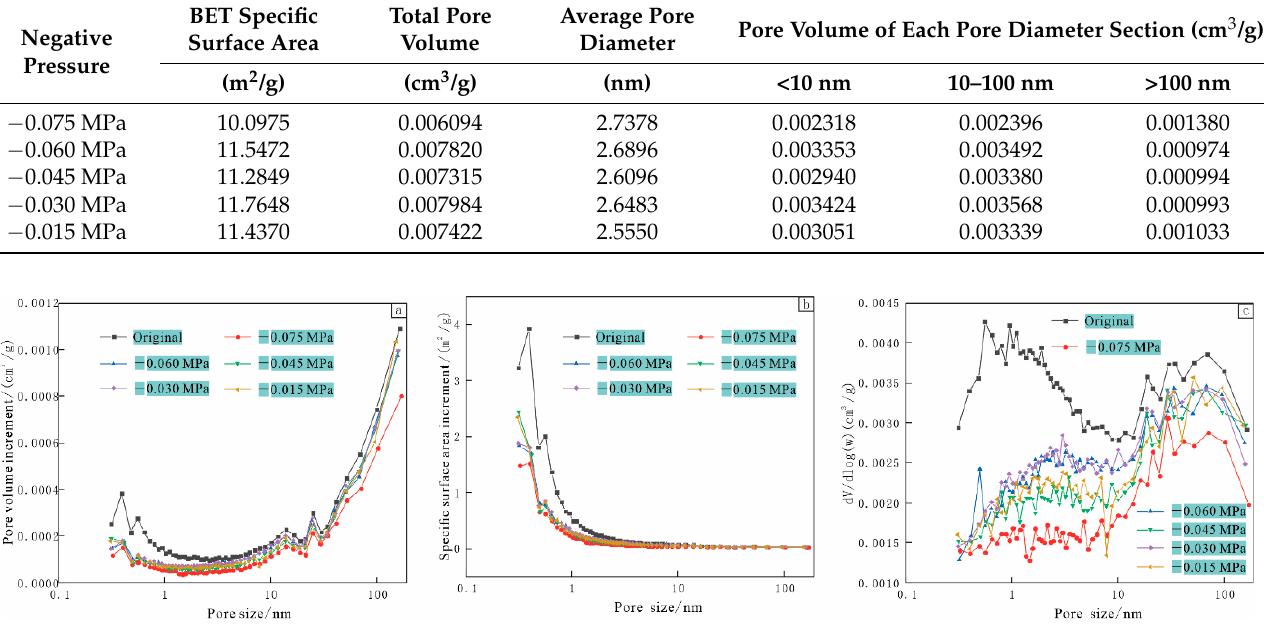
Figure 5. ( a – c ) Dynamic changes in the characteristics of the pore structure parameters of the low-rank coal samples under different negative pressure conditions.